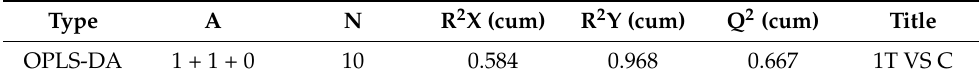
Table 2. OPLS-DA model parameter table. The model parameters are the comparison between the treatment group and the control group. A is the number of principal components of the model, N is the number of observations of the model (here, it is the number of samples), R 2 X represents the model’s interpretation of X variable, R 2 Y represents the model’s interpretation of Y variable, and Q 2 represents the predictability of the model. Type A N R 2 X (cum) R 2 Y (cum) Q 2 (cum) Title OPLS-DA 1 + 1 + 0 10 0.584 0.968 0.667 1T VS C